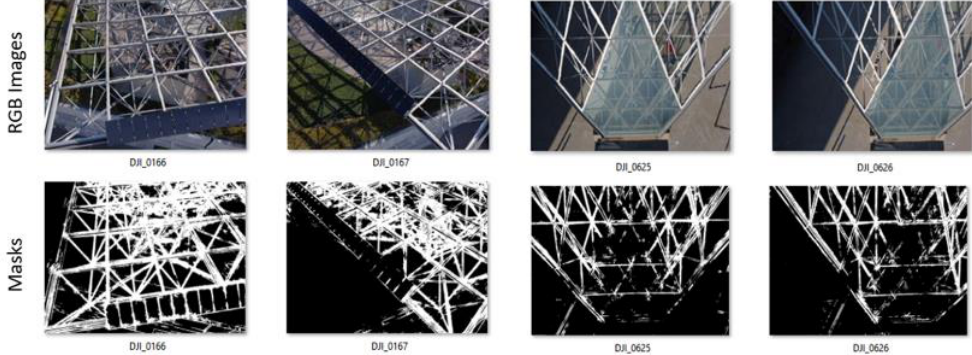
Figure 22. Masks resulting from the first attempt.